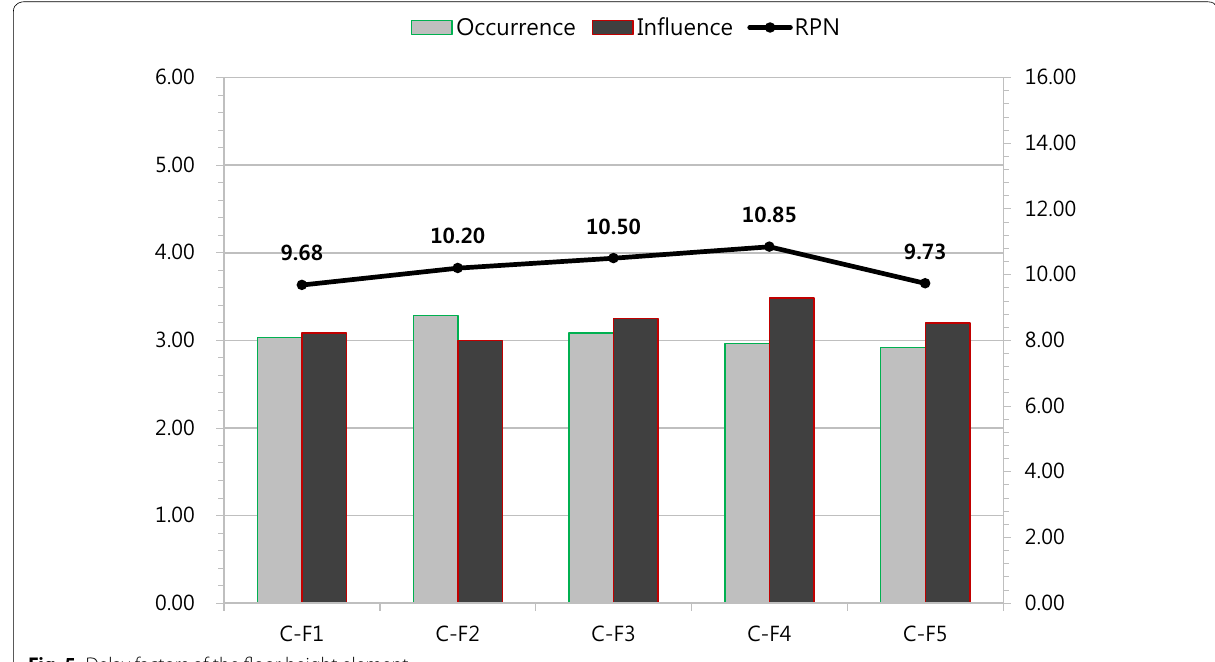
Fig. 5 Delay factors of the floor height